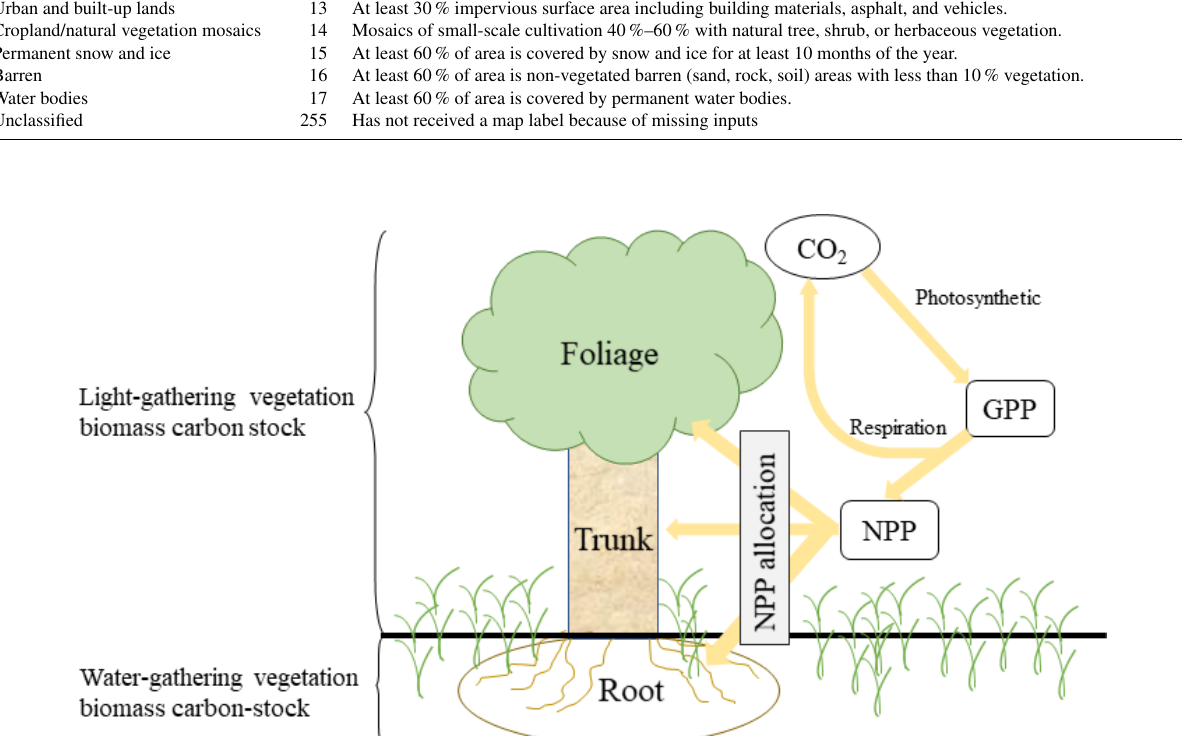
Figure A1. Schematic of ecosystem carbon cycle. Yellow arrow indicates carbon flux. Atmospheric CO 2 transitions into gross primary production (GPP) by photosynthesis. GPP is partitioned into respiration and net primary production (NPP). NPP is partitioned into three biomass carbon pools (foliage, trunk, and